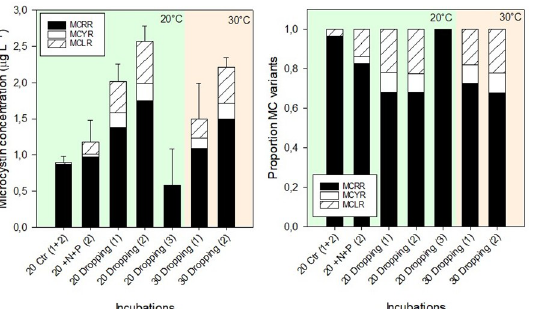
Fig 5. Microcystin concentrations in several treatments. (A) Concentrations of three microcystin (MC) variants ( μ g L -1 ) and (B) mean proportions of three different MC variants in the total MC pool in surface water sampled from three locations (Site 1,2,3) in Lake Lesser Prespa. The water had been incubated for seven days at 20˚C and 30˚C, without extra nutrients added (Control), with solely N-added (+N), solely P-added (+P), both N+P added (+N+P) and pelican droppings added (Dropping). Error bars indicate one standard deviation (n = 4 for Control (site 1 and 2), n = 3 for others).